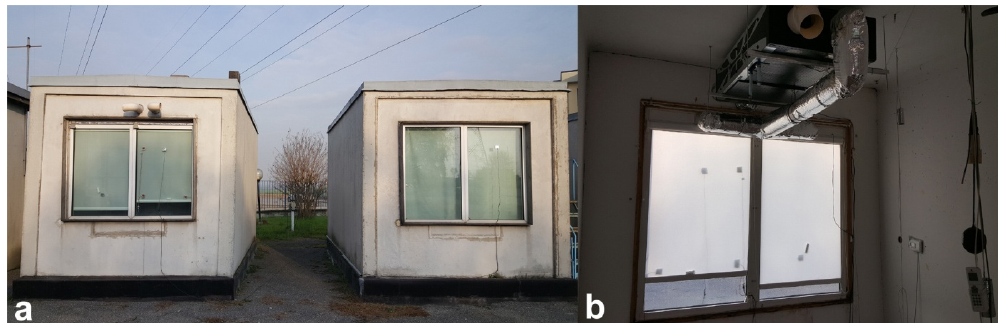
Figure 2. ( a ) Outside view of the test cells: C2 on the right side, C3 on the left side; ( b ) Internal view of C3.